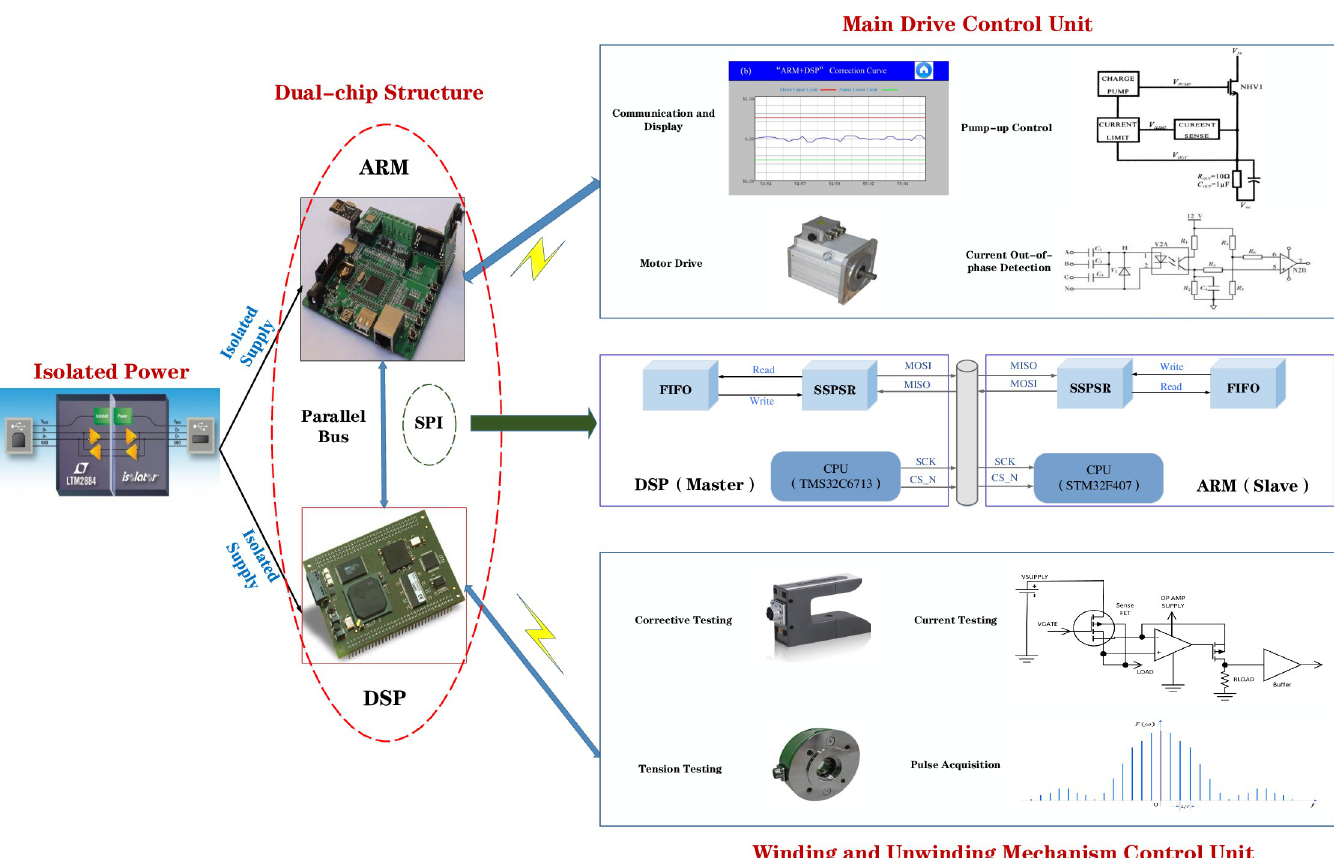
Fig 17. Hardware architecture block